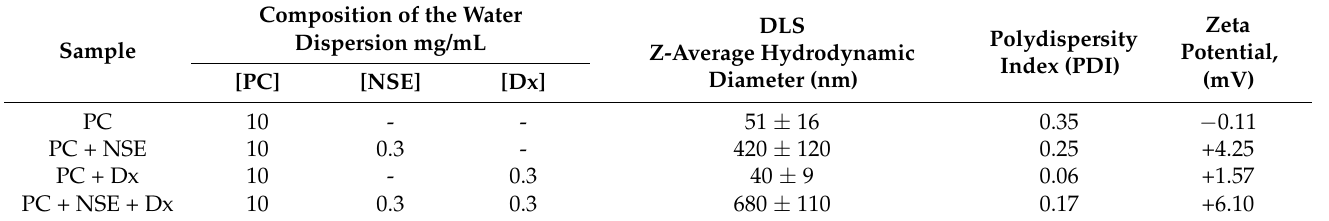
Table 1. Physico-chemical characteristics of the polymeric carrier poly(VEP-co-GMA)-graft-mPEG and its complex with NSE and Dx.